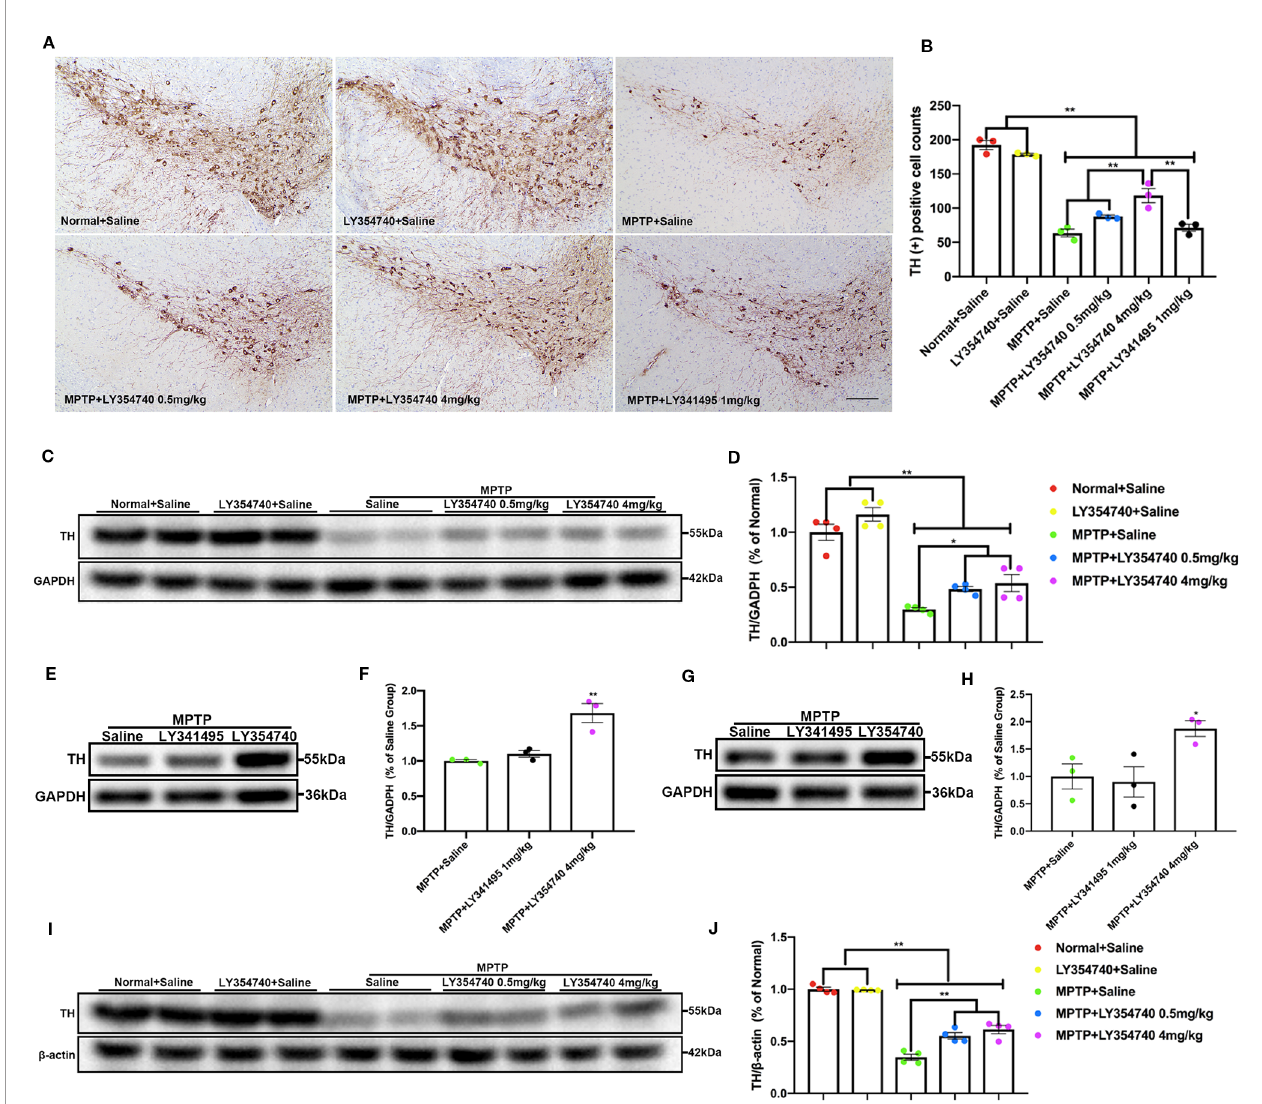
FIGURE 6 | The effect of ligands of mGlu 2/3 receptors on expression of tyrosine hydroxylase (TH) in substantia nigra (SN) and striatum in acute 1-methyl-4-phenyl- 1,2,3,6-tetrahydropyridine (MPTP)-induced Parkinson ’ s disease (PD) mice models. (A) Immunohistochemical images of tyrosine hydroxylase (TH) in SN of each group. Scale bar = 100 m m. (B) Analysis of differences in TH positive cell counts in SNc from each group. ** p < 0.01. N = 3. Error bars represent SEM. Western blot analysis showed levels and relative quanti fi cation of TH in acute-MPTP mice in SN (C – F) of each group. * p < 0.05, ** p < 0.01, N = 4 in (D) ; ** p < 0.01 vs. other groups; N = 3 in (F) . Western blot analysis showed the levels and relative quanti fi cation of expression of TH in striatum (G – J) of acute-MPTP mice treated with different doses of LY354740. * p < 0.05 vs. the other groups; ** p < 0.01. N = 4 in (J) , N = 3 in (H) . Data are expressed as % of the normal + saline group in (D, J) . Data are expressed as % of the MPTP + saline group in (F, H) . Error bars represent